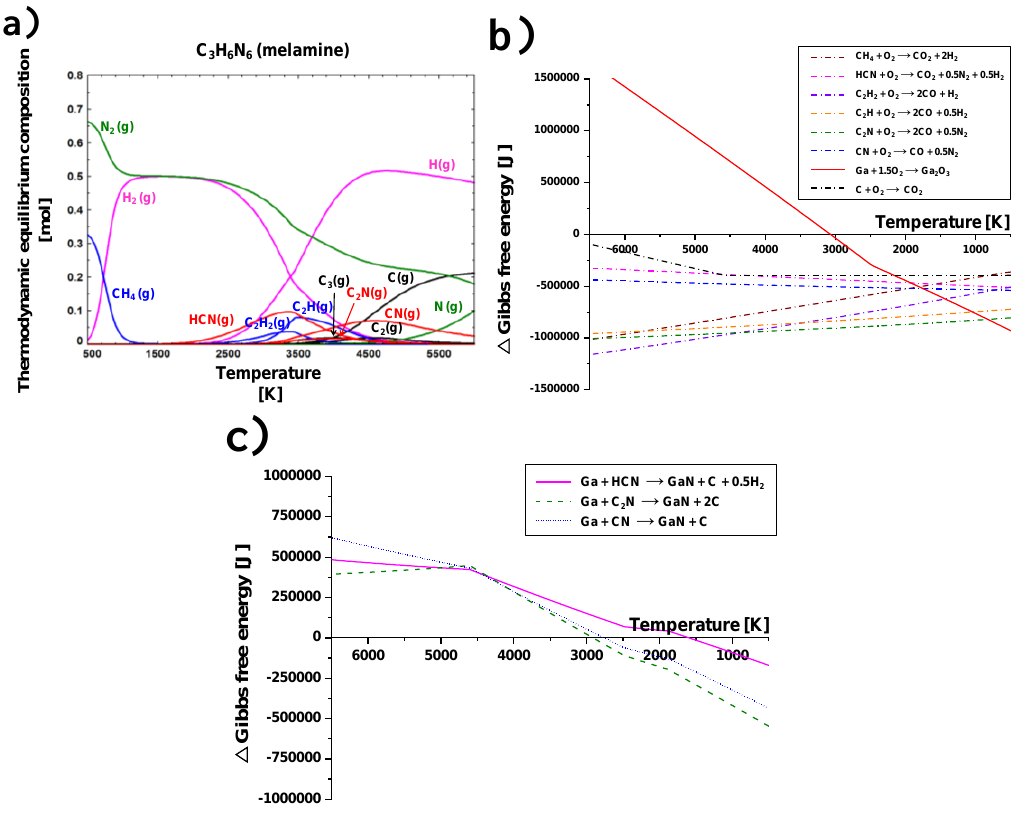
Figure 4. Thermodynamic equilibrium calculation at changes in temperature; ( a ) thermodynamic equilibrium composition of melamine; ( b ) change in Gibbs free energy during the oxygen capture reaction of C 3 H 6 N 6 from Ga(NO 3 ) 3 ∙ x H 2 O; and ( c ) change in Gibbs free energy of nitridation reaction by decomposed C 3 H 6 N 6 .